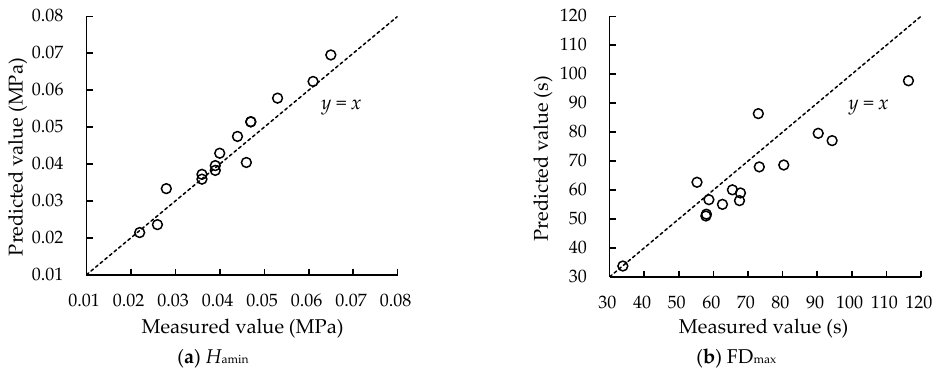
Figure 6. Comparison of measured and predicted values by the regression model for the automatic flushing valve .